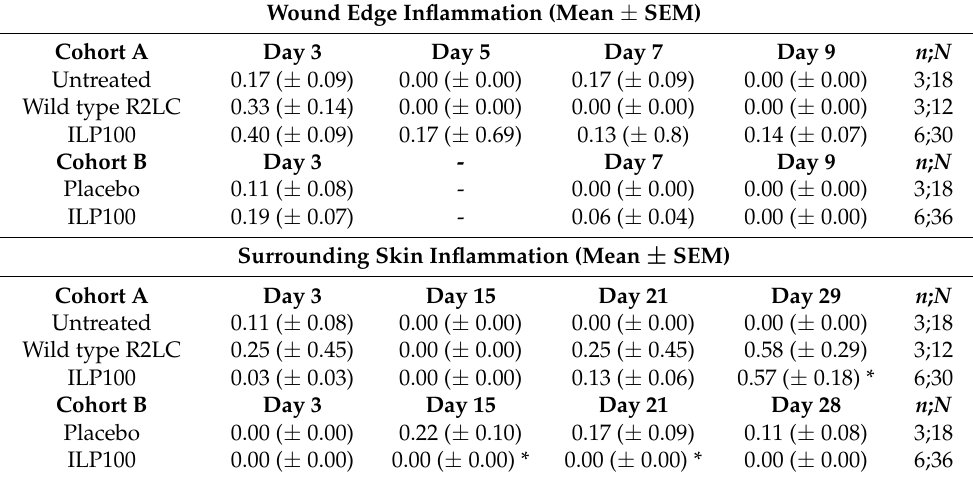
Table A2. Average score (0–4) for wound edge inflammation and inflammation in the surrounding skin for untreated wounds, wounds treated with wild type L. reuteri R2LC or ILP100 in Cohort A and wounds treated with placebo or ILP100 wounds in Cohort B. For time points not included in the table all wounds in all groups were scored as 0.